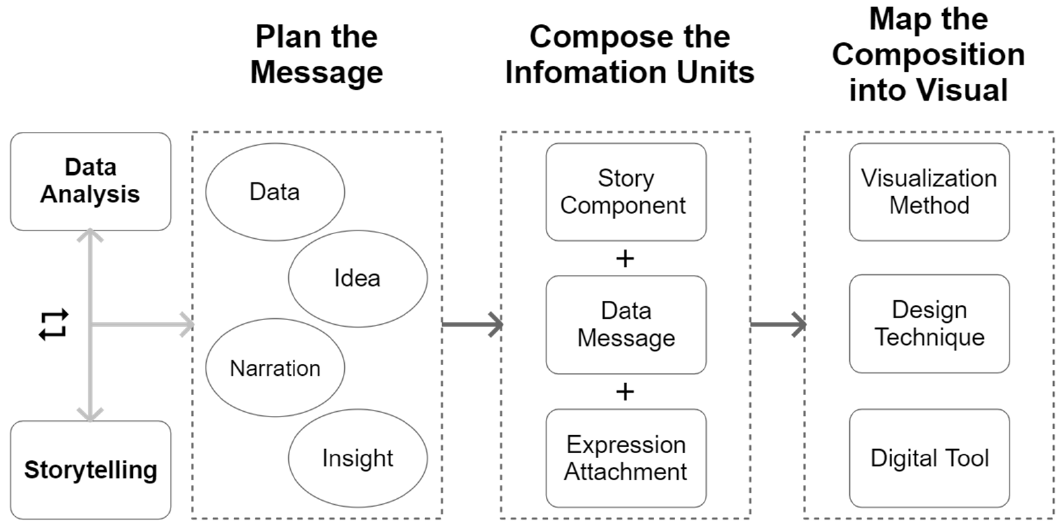
Figure 1. Conceptual overview of our visual data storytelling approach.